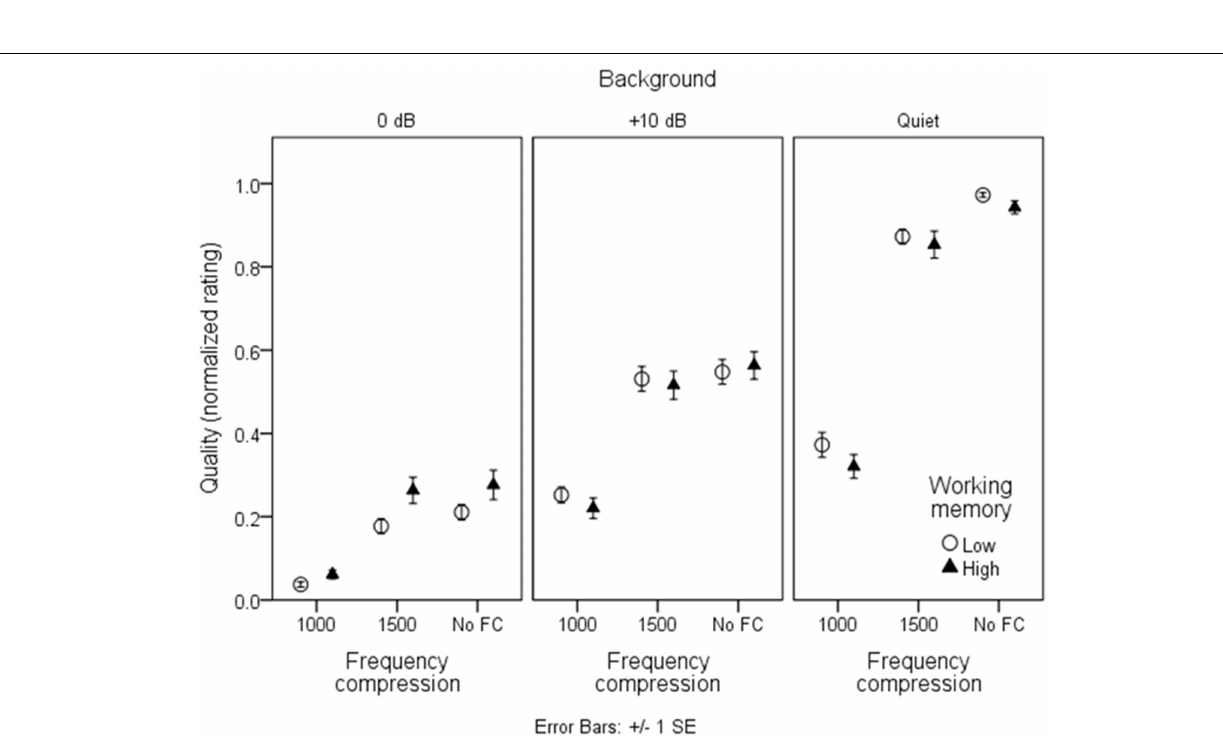
FIGURE 8 | As in Figure 3, but for quality ratings grouped by frequency compression